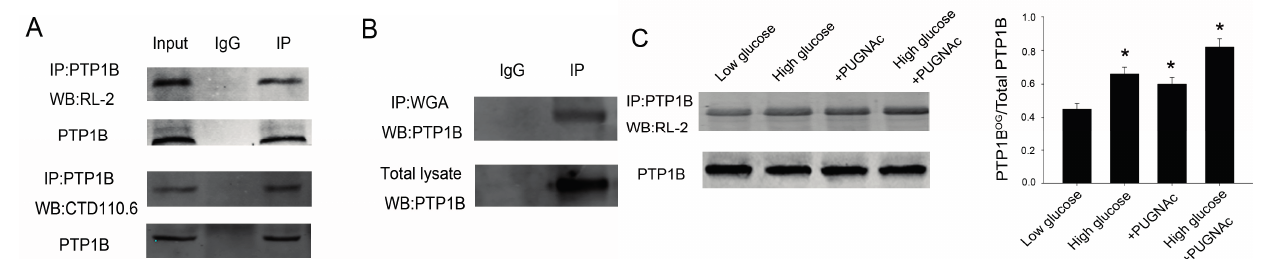
Figure 1. PTP1B is modified by O -GlcNAcylation. ( A ) To detect whether PTP1B is O -GlcNAcylated, PTP1B was immunoprecipitated from 500 μ L lysate of HepG2 cells with 5 μ L PTP1B antibody and analyzed by western blot with RL-2 and CTD110.6 antibody. Input was used as positive control. IgG was a negative control; ( B ) Cell lysate was immunoprecipitated with WGA agarose beads followed by PTP1B antibody; ( C ) HepG2 cells were incubated for 24 h under low (5 mmol/L) or high (25 mmol/L) glucose conditions and treated with or without the O-GlcNAcase inhibitor PUGNAc. Then PTP1B was immunoprecipitated and analyzed by western blot with RL-2 antibody. IP, immunoprecipitation; WB, western blot. Data show mean ± SEM of three